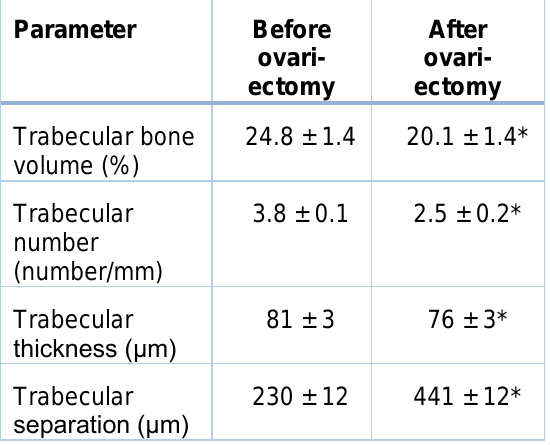
After ovari- ovari- ectomy ectomy 24.8 ±